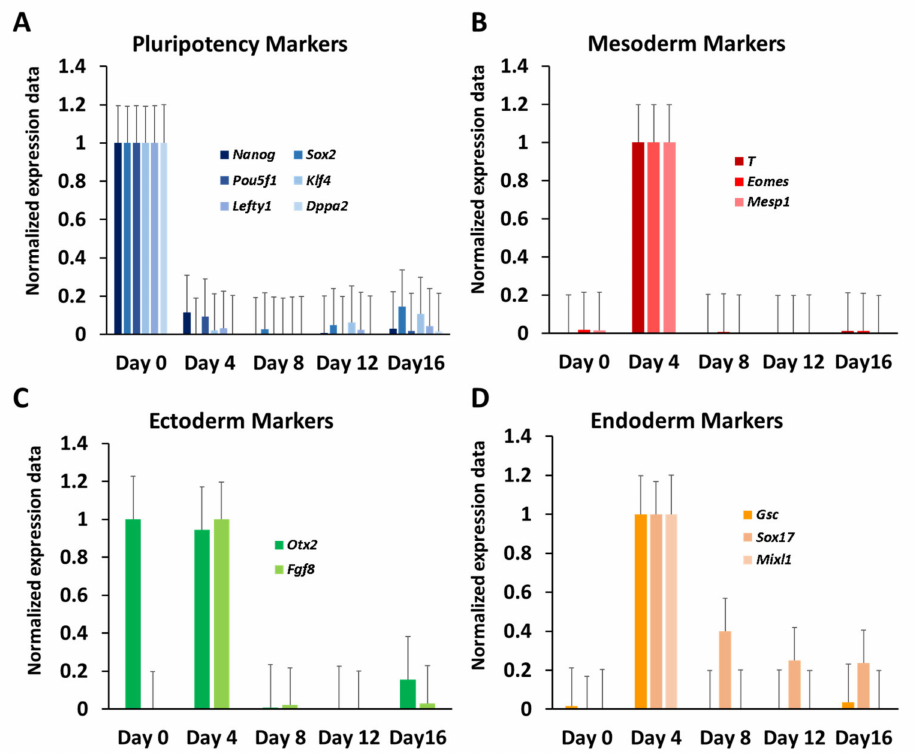
Figure 3. Expression of marker genes. ( A ) Pluripotency markers; ( B – D ) mesoderm, ectoderm and endoderm markers. Expression values for each gene were normalised to have a minimum value of 0 and a maximum value of 1. Standard error bars are shown.